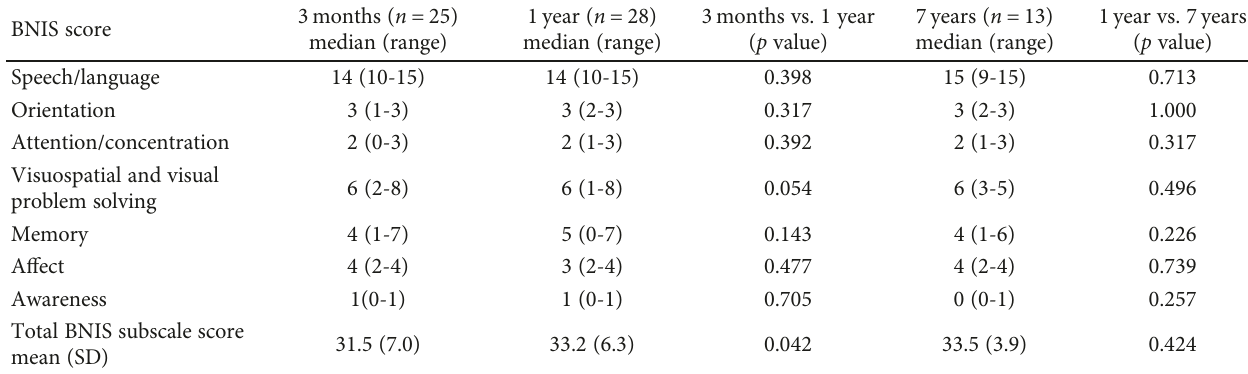
Table 4: BNIS subscale scores and total BNIS scores at 3months, 1year, and